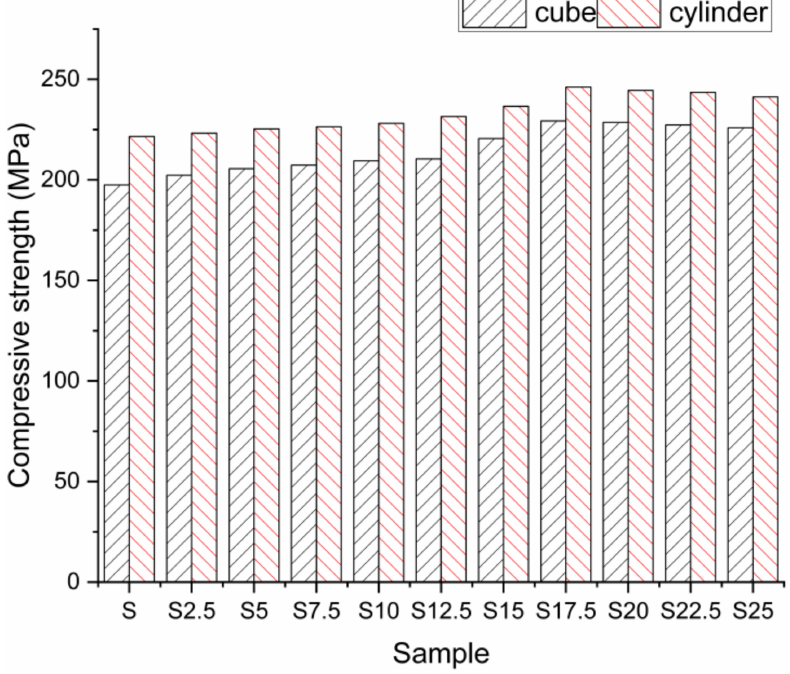
Figure 2. Compressive strength results of cube and